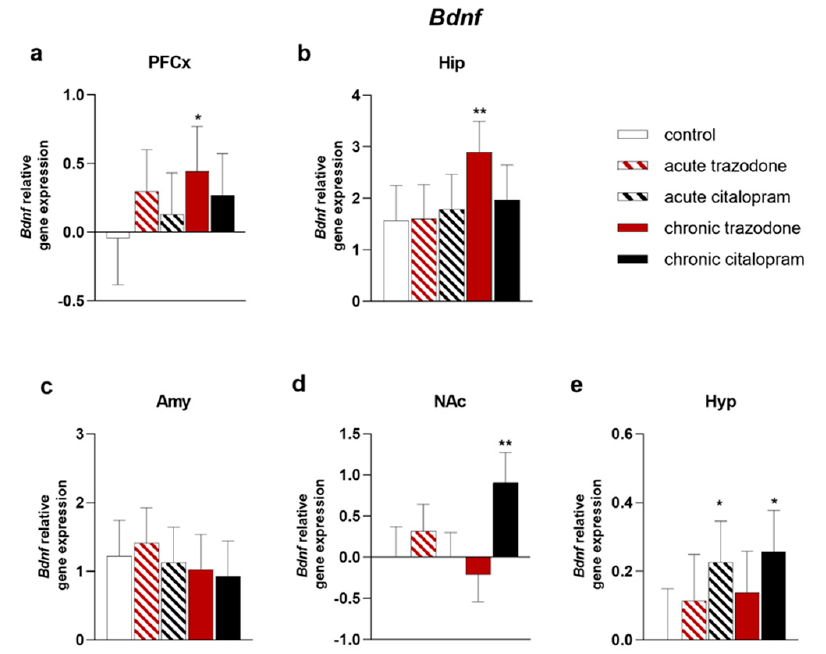
Figure 1. mRNA levels of Bdnf in the PFCx ( a ), Hip ( b ), Amy ( c ), NAc ( d ), and Hyp ( e ) after acute or chronic treatment with trazodone, citalopram, or vehicle. The least square predicted means with 95% confidence intervals are plotted. Data were log-transformed when required to stabilise the variance and satisfy the parametric assumptions ( a , d , e ). **: p < 0.01; *: p < 0.05 in the Planned Comparison vs. control. N = 6/group.